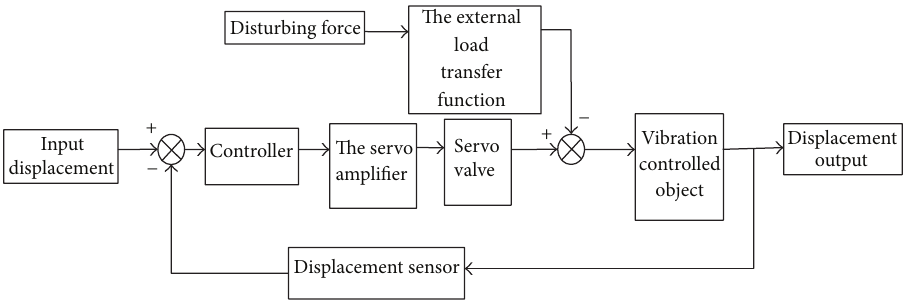
Figure 2: Block scheme of the hydraulic servo control